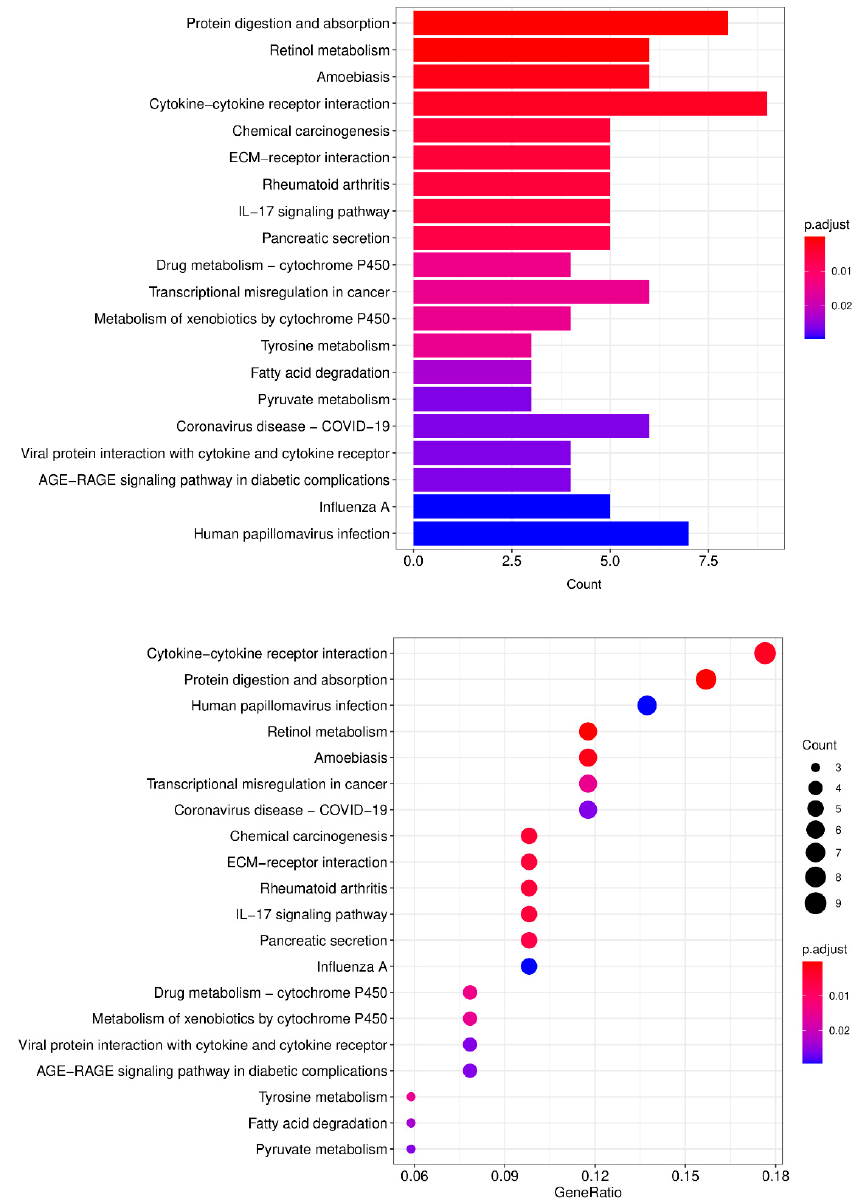
Figure 4. KEGG enrichment analysis results of the DEGs.